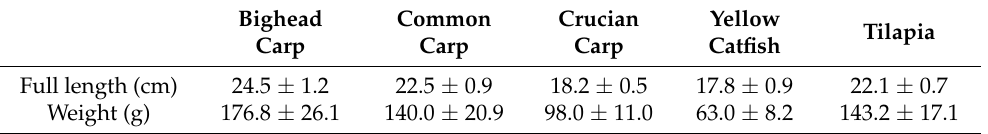
Table 1. Specifications of host fishes (mean ± SD; n =